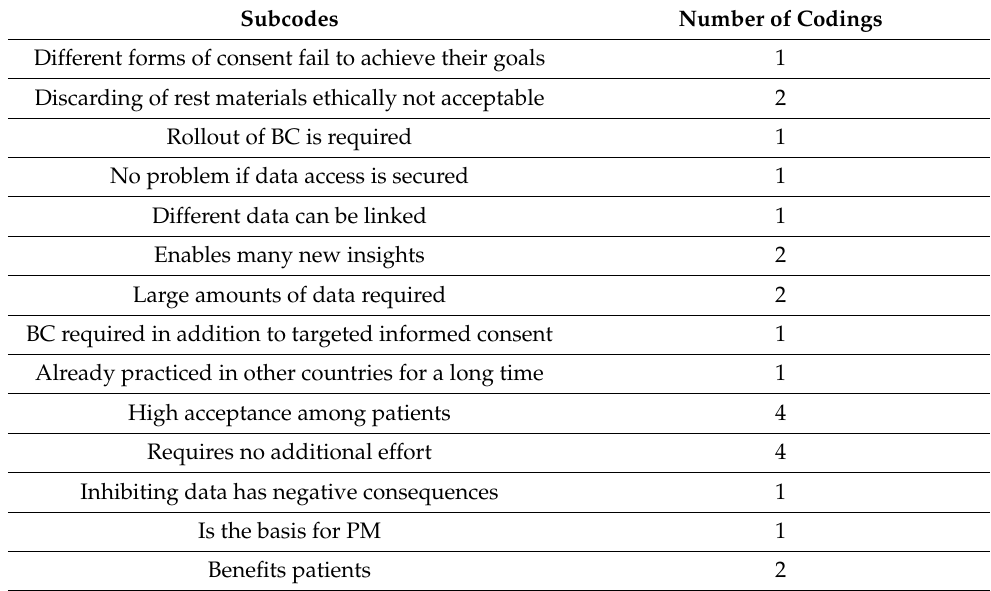
Table 3. Positive Evaluation of the Broad Consent (BC). Subcodes Number of